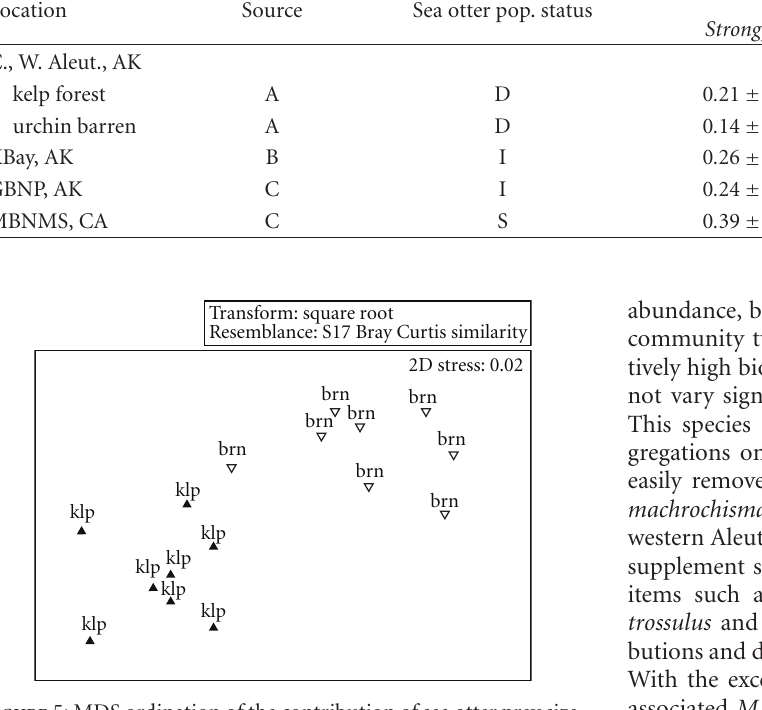
Figure 5: MDS ordination of the contribution of sea otter prey size, abundance, biomass, and energy density to the gradient in separa- tion of remnant kelp forest and urchin barren communities in the central and western Aleutian Islands, Alaska. Kelp forests (klp) and urchin barrens (brn) are